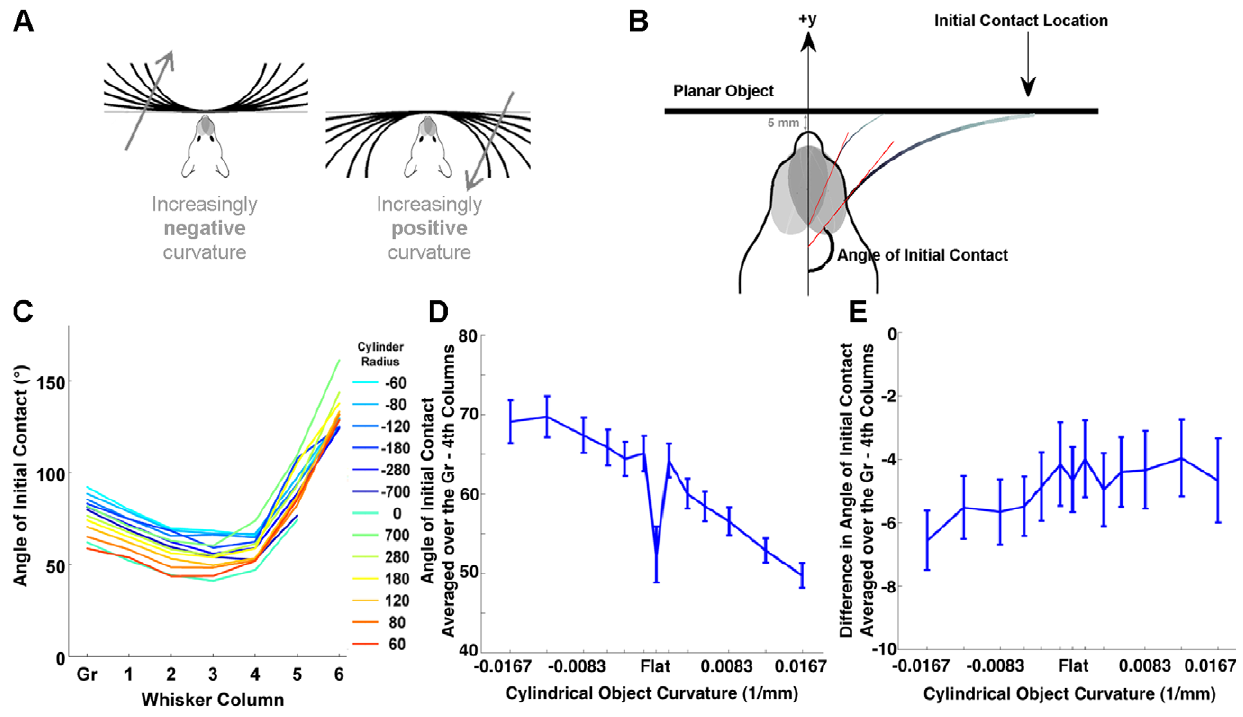
Figure 11. Array morphology constrains the information available to the nervous system about object curvature. ( A ) Schematic showing the different cylinder radii tested. Negative radii and curvature were defined such that the convex face of the object faced the rat. Note that the cylinder approaches a plane as the radius goes to infinity and curvature goes to zero. ( B ) Schematic illustrating the calculation of the angle of initial contact. Red dashed line indicates the angle at the base of the whisker at which the whisker makes its first contact with the object. This figure also illustrates a situation in which a more rostral whisker will contact at a more protracted angle than a more caudal whisker. ( C ) Angles of initial contact are shown for each whisker of the C row. Each trace represents results for a cylinder with a different radius, color coded as shown in the legend. Gr indicates the gamma whisker. ( D ) Average angle of initial contact versus cylinder curvature (1/radius). The most curved cylinders are represented at the graph extremes. ( E ) Difference across columns in the average angles of initial contact versus cylinder curvature. In both D and E, error bars indicate the standard error of the mean (averaged across all whiskers in the model).